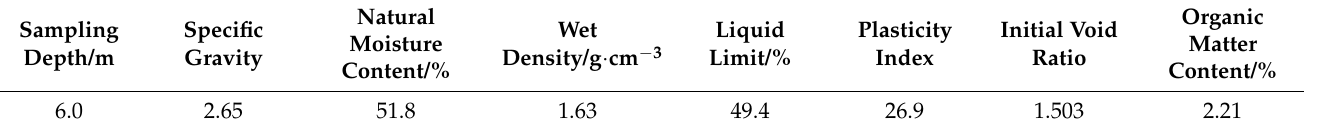
Table 1. Physical characteristics of test soil.